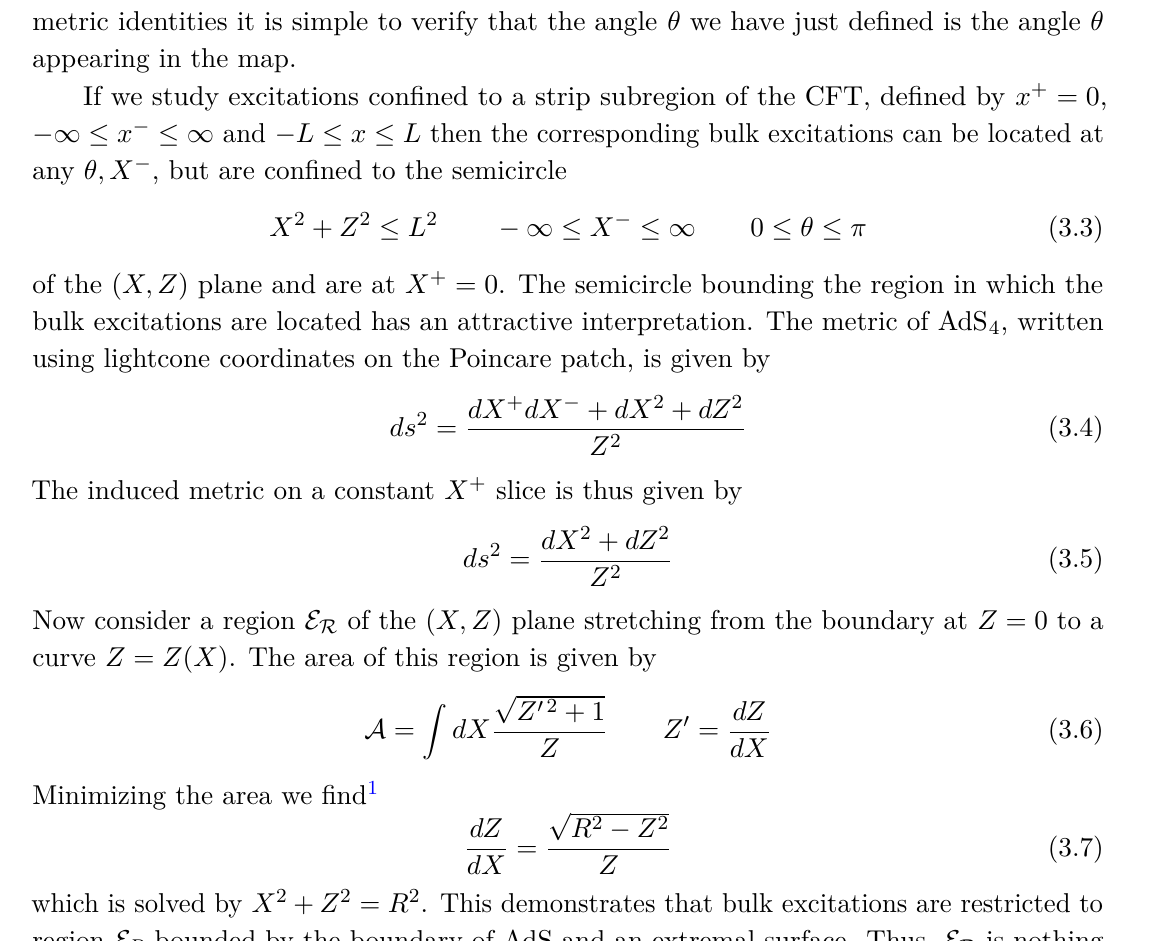
Figure 1 . The bilocal describing a pair of excitations localized at ( x 1 , p + to a bulk excitation localized at ( X, Z ) as shown. The bilocal CFT excitation (two red circles) maps into a bulk excitation on the semicircle above. This figure lives on a constant x + = X + slice. The angle θ is related to p + and p + according to 1 2